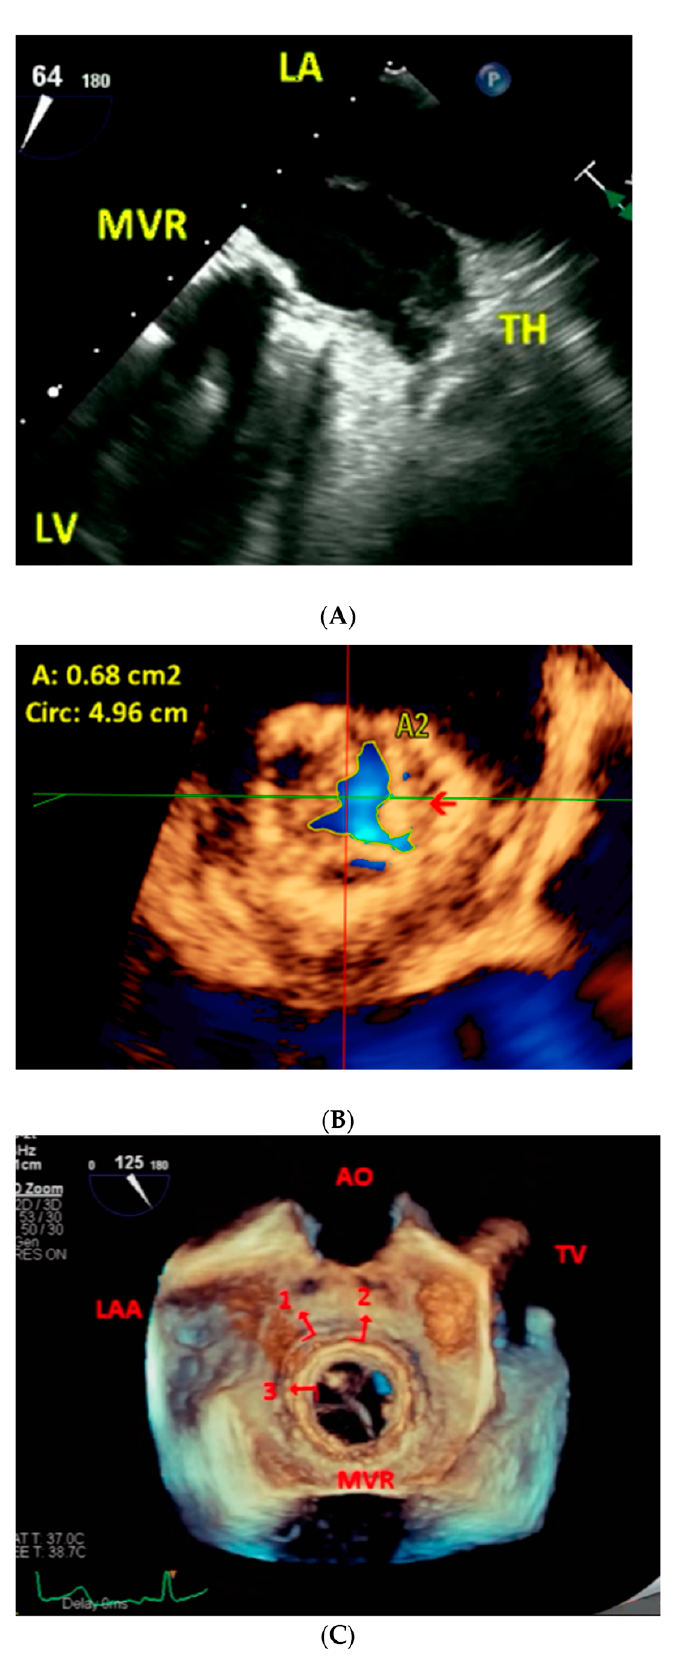
Figure 3. ( A – C ). The same patient (Case 2 above) returned 2 years and 8 months later with severe stenosis of the new MVR. Pre-procedure. Two-dimensional transesophageal echocardiography ( A ).